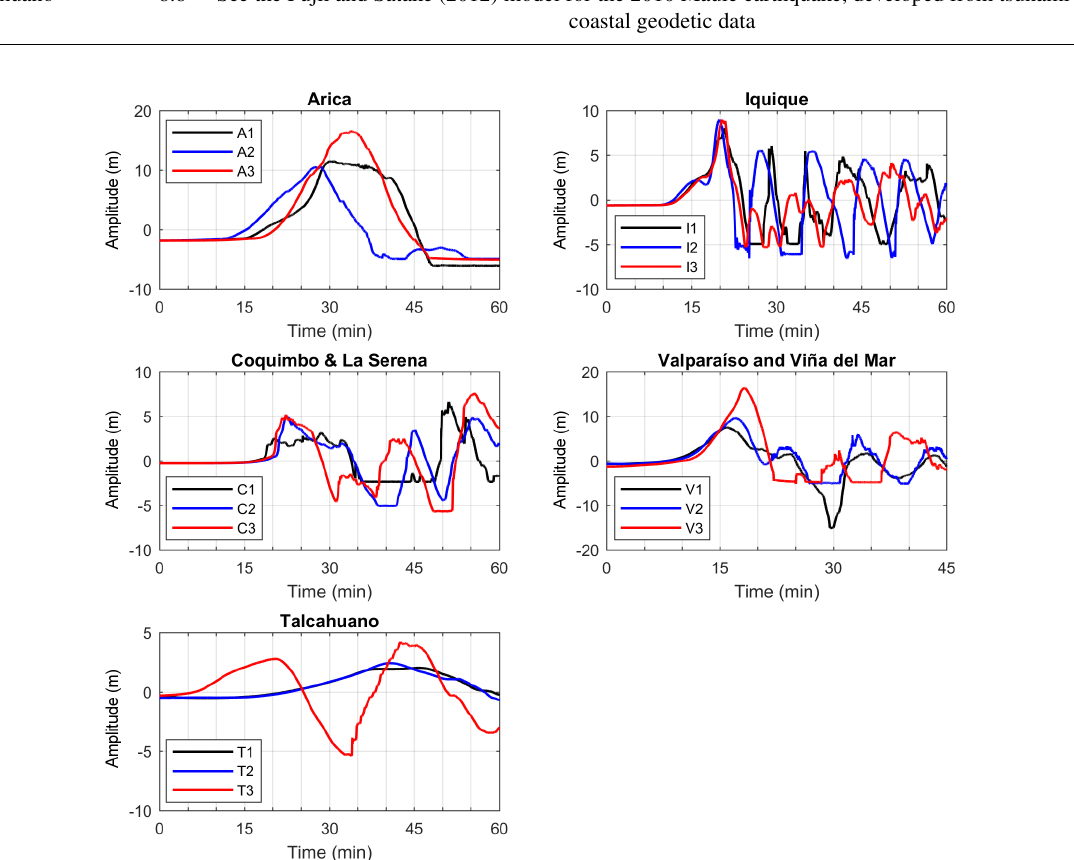
Figure 3. Tsunami time series for the examined case studies, as measured by virtual gauges (see their locations in Fig.